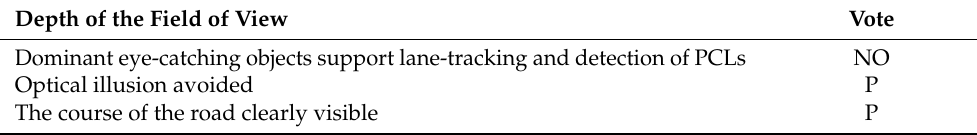
Table 10. Evaluations of the “depth of the field of view” investigation